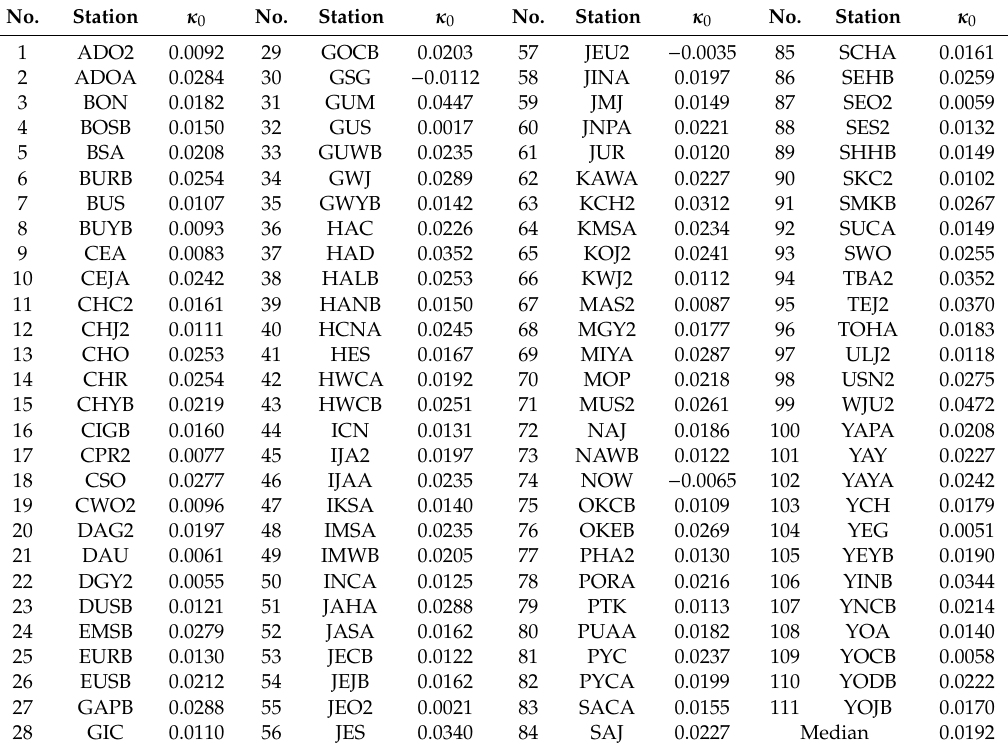
Table A1. κ 0 values for 111 stations.